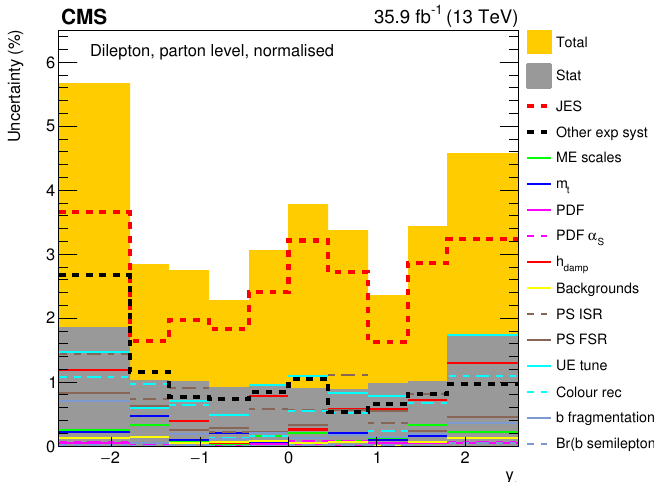
Figure 14 . The contributions of each source of systematic uncertainty to the total systematic uncertainty in each bin is shown for the measurement of the normalised tt production cross sections as a function of y t . The sources a(cid:11)ecting the JES are added in quadrature and shown as a single component. Additional experimental systematic uncertainties are also added in quadrature and shown as a single component. Contributions from theoretical uncertainties are shown